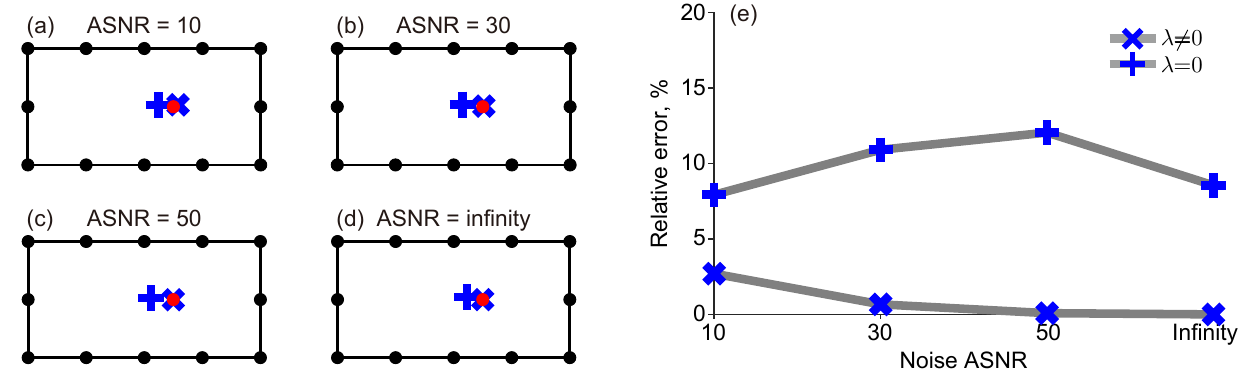
Figure 6. Numerical experiment results with noise ASNRs 10, 30, and 50 and without noise. Here, ASNR is defined as in Equation (7). For simplicity of notation, the ASNR in the absence of noise is expressed as ∞ . The estimated location is represented in ( a – d ), where ASNR is 10, 30, 50, and ∞ , respectively. The black dots are for sensor positions, while red dots represent crack positions. The blue plus sign (+) and blue cross mark (x) denote the estimated crack positions for λ = 0 and λ (cid:54) = 0, respectively. The relative error for noise is shown in ( e ) with a blue plus sign (+) when λ is zero and blue cross mark (x) when λ is